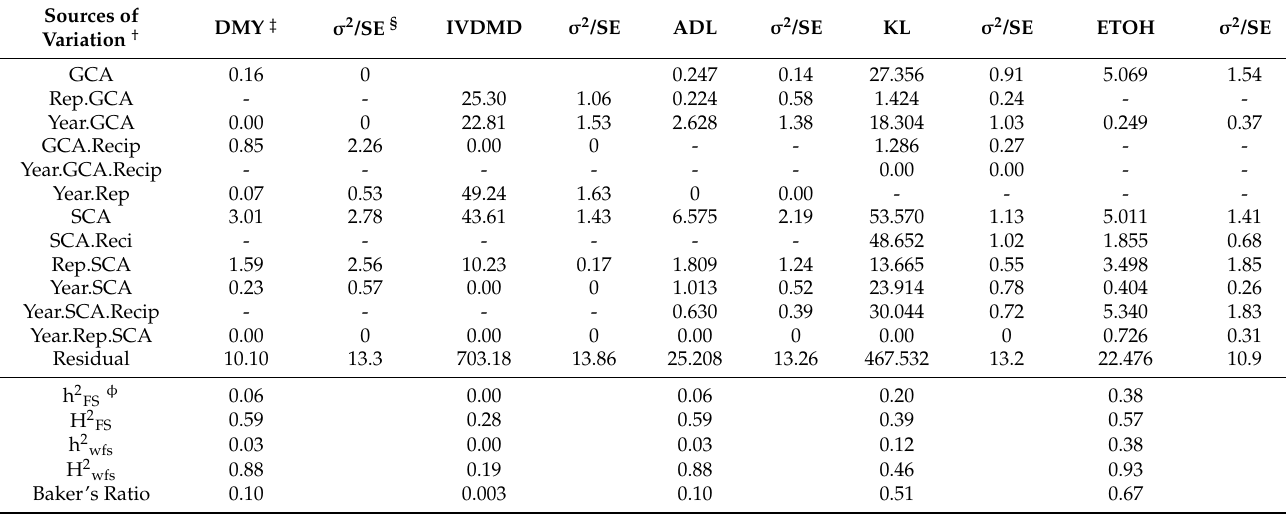
Table 2. Heritability values, Baker’s ratios, and significance of variance components obtained from parental crosses derived from three switchgrass ecotypic